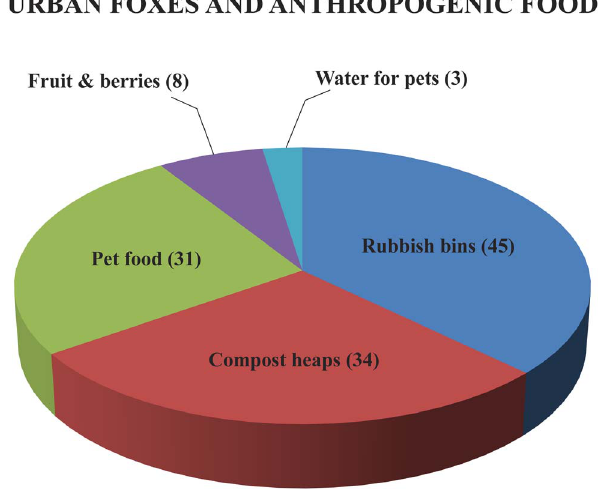
Fig. 4. Food types exploited by urban foxes in Estonia (see also Table 1). Numbers indicate the number of people reporting fox